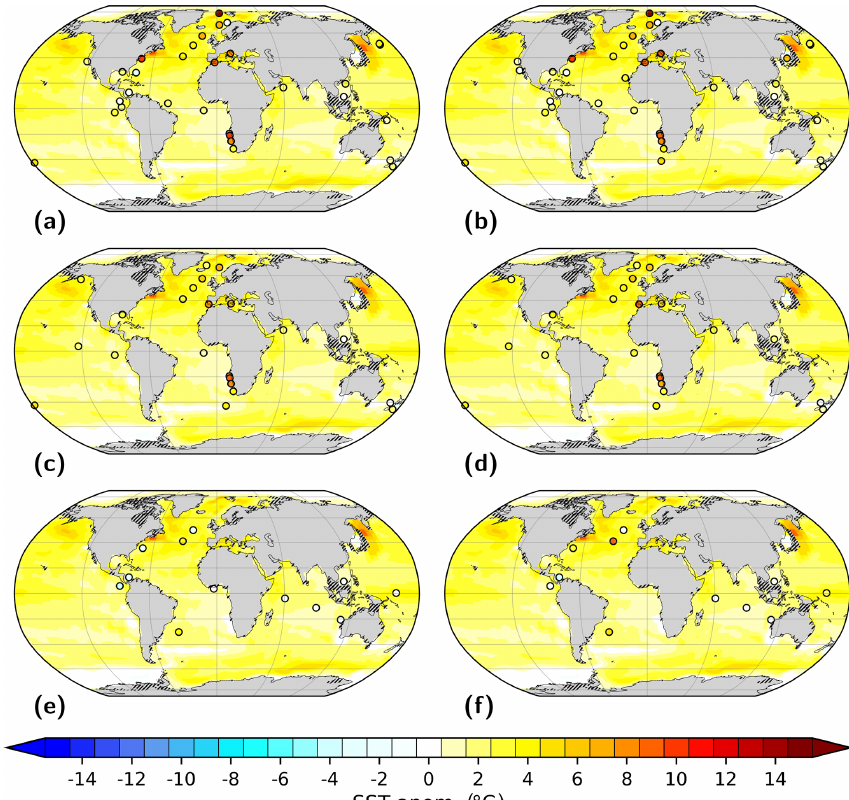
Figure 24. Comparison of modelled and reconstructed sea surface temperature (SST) anomaly of simulation Eoi400 with respect to pre- industrial (PI, E280). Shown are (a) alkenone (U K ) with a 10kyr window (Foley and Dowsett, 2019), (b) U K with a 30kyr window (Foley 37 (cid:48) 37 (cid:48) and Dowsett, 2019), (c) U K PlioVAR synthesis (McClymont et al., 2020), (d) U K BAYSPLINE (McClymont et al., 2020), (e) magnesium- 37 (cid:48) 37 (cid:48) to-calcium ratio (Mg / Ca) PlioVAR synthesis (McClymont et al., 2020), and (f) Mg / Ca BAYMAG (McClymont et al., 2020) – see text for details with regard to reconstructions. Shading represents modelled annual mean SST anomaly. Circles illustrate the temperature anomaly of the respective mid-Pliocene SST reconstruction. Grey shading illustrates the land–sea mask. Hatches over land indicate differences in land– sea configuration between Eoi400 and the E280 reference. We define model SST as the temperature of the uppermost ocean layer centred around a dept of